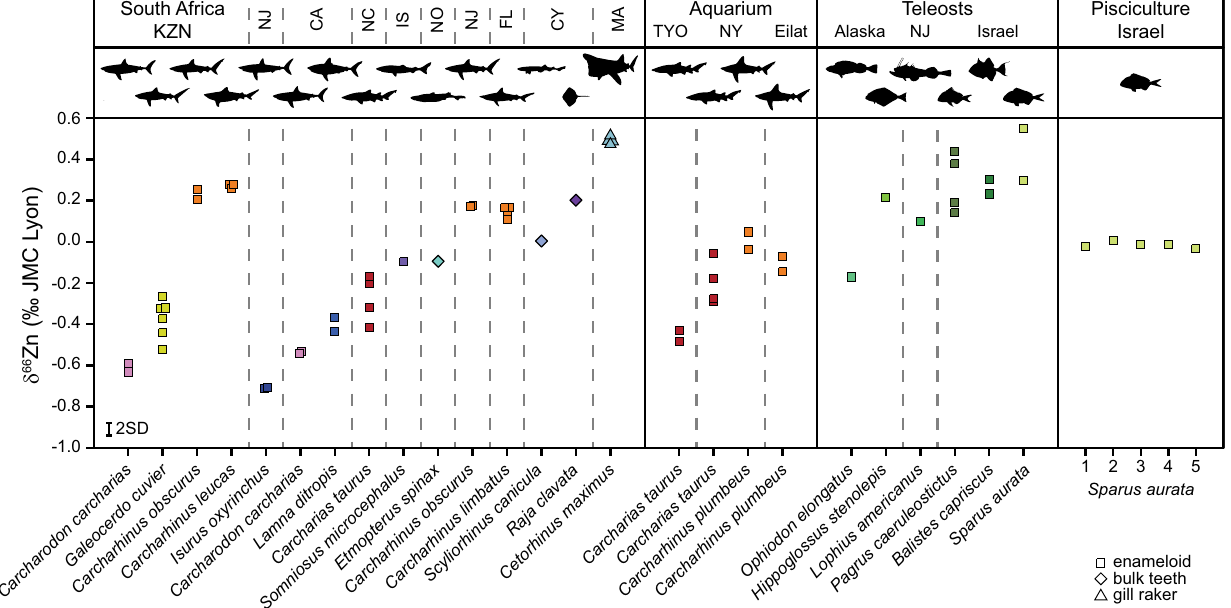
Fig. 1 Zinc isotope ( δ 66 Zn) composition of extant elasmobranch and teleost fi sh teeth and gill raker. Specimens come from off the coast of KwaZulu- Natal (KZN) South Africa, New Jersey (NJ), California (CA), North Carolina (NC), Iceland (IS), Norway (NO), Florida (FL), Cyprus (CY), Massachusetts (MA), Alaska and Israel. Aquarium sharks are from the New York (NY) and Tokyo (TYO) Aquariums and the Eilat (Israel) Underwater Observatory Park. Pisciculture S. aurata individuals are numbered and plotted individually to visualise the homogeneity among control-fed individuals compared to wild elasmobranchs and teleosts. Silhouettes are not to scale. Measurement uncertainty is indicated at the 2 SD level. Samples are colour-coded following their genus, regardless of locality. Source data are provided as a Source Data fi